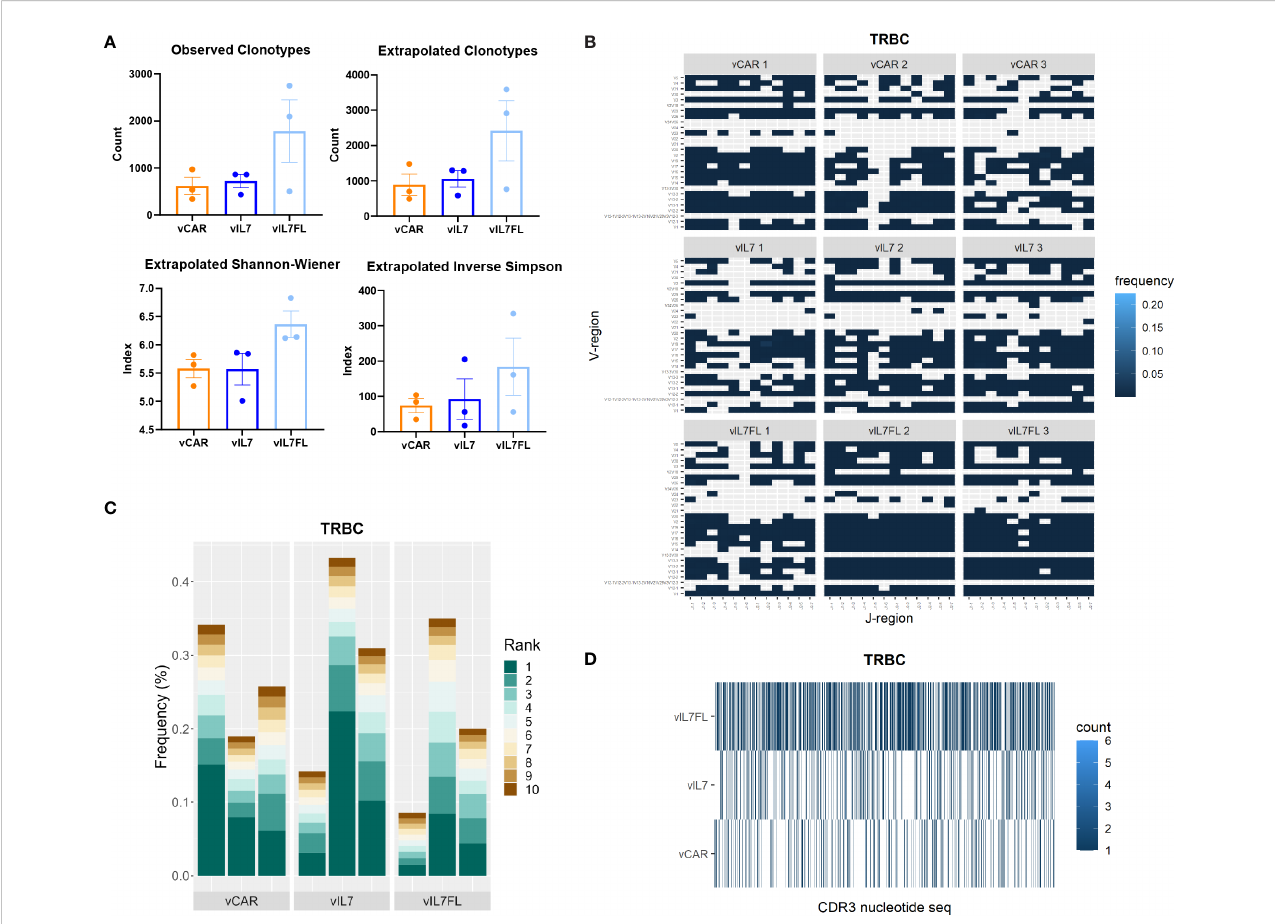
FIGURE 5 TRBC diversity of IL7 Flt3L co-expressing CAR T cells. Animals were inoculated with 50% vIII and 2A tumor cells and IVIS imaged 5 days later. On day 7, 0.5 Gy TBI was applied and 2x10^6 CAR T cells were injected intracranially the following day. RNA was extracted from the tumor-bearing hemisphere 7 days post CAR T cell injection and processed for immune repertoire sequencing (n = 3). (A) Diversity metrics of TRBC. Statistical analysis was a Kruskal-Wallis test with Dunn ’ s multiple comparisons. (B) Heat map of V and J pairings of TRBC. (C) The frequency of the top 10 clonotypes of TRBC. (D) Visualization of TRBC clonotypes combing biological